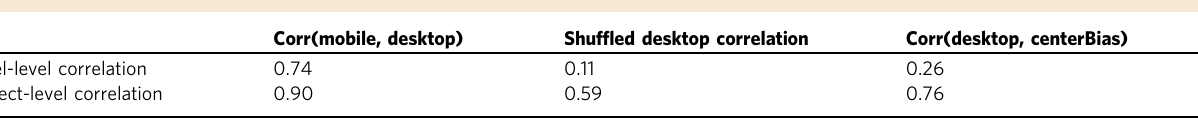
ColumnsshowPearson ’ scorrelationbetweenthedesktopand(1)mobileheatmapfromourstudy;(2)desktopheatmapfromarandomlyselectedimage;(3)Gaussiancenteredattheimage.Rowsshow the pixel- and object-level